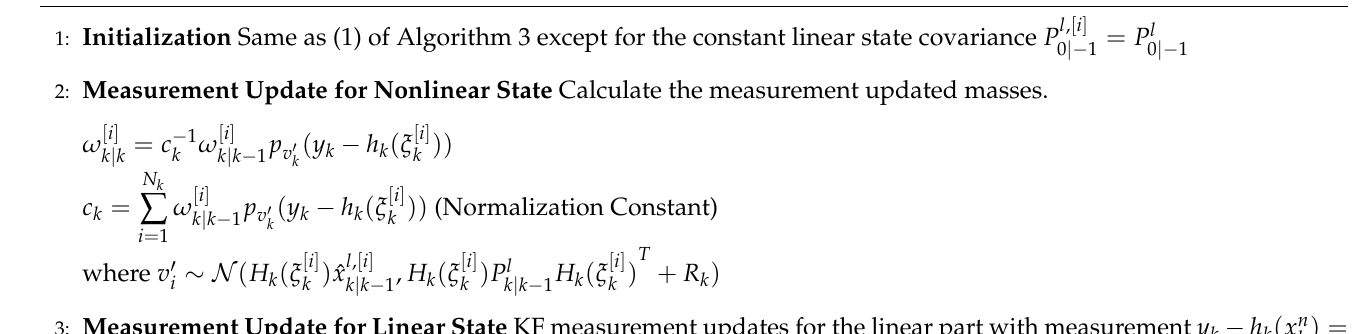
Algorithm 5 RBPMF with Indirect Time Propagation for Constant Linear